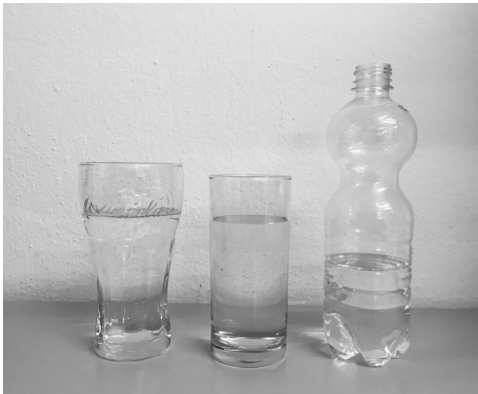
Figure 1. The three drinking receptacles used in Cavazzana et al.’s (2017) [30] study: A typical cola glass (left), a typical water glass (middle), and a plastic bottle (right). Note that each container was filled with 200 mL of liquid. Reproduced with permission from [30], © 2017 Elsevier Ltd.